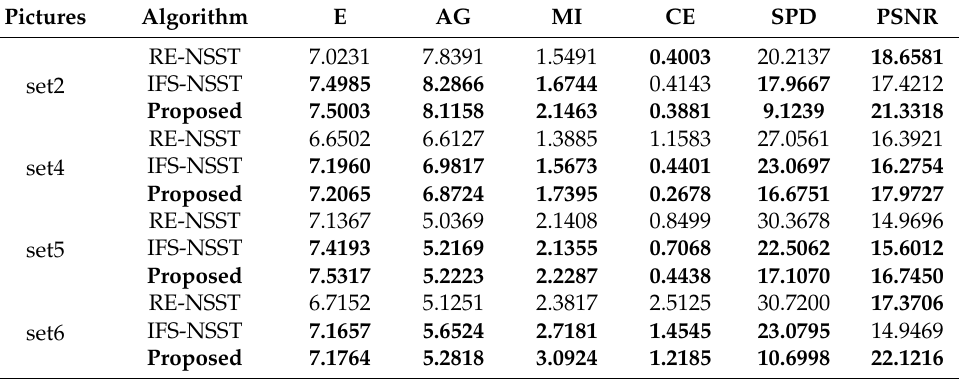
Table 1. Quantitative comparison results of RE-NSST, IFS-NSST, and proposed